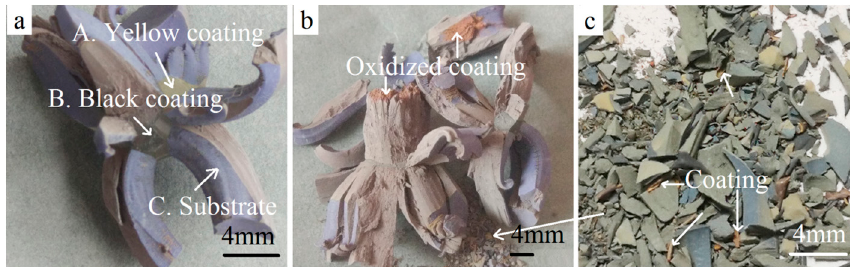
Figure 5. Magnified macrographs of fragments oxidized at 900°C for different holding time. ( a ) 180 min; ( b , c ) 300 min.